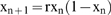
Verhulst system: oscillatory pattern and phase-space representation.Verhulst system standard values for the constants were set as follows:with r = 3.72. Left panel: Ordinate: oscillatory behavior of variable x. Abscissa: time. Right panel: phase-space representation of the attractor. Chaotic (top) and birhythmic (bottom) conditions are compared.